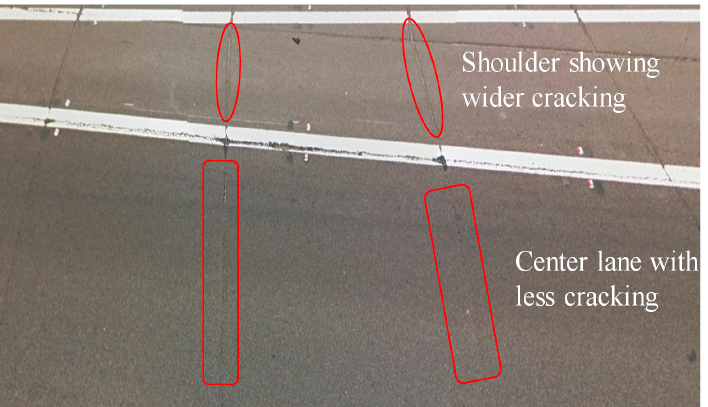
Figure 1. Crack severity comparison between shoulder and driving lane (source: map-highway 101, Tempe Arizona).